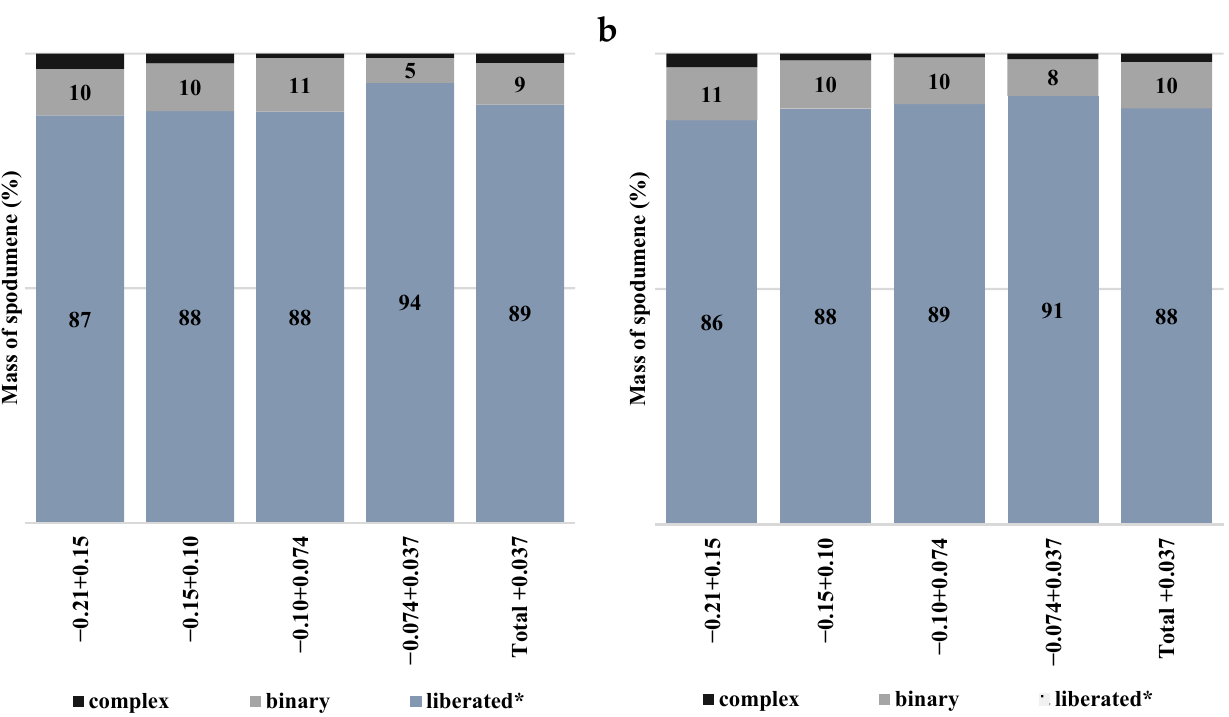
Figure 8. Spodumene liberation characteristics for G1 ( a ) and G2 ( b ). Liberation is based on spo- dumene area (liberated ≥ 95% spodumene). Binary particles are composed of spodumene and another mineral phase, whereas complex particles are composed of spodumene and two or more different mineral phases. *: Grains with ≥ 95% spodumene in area.